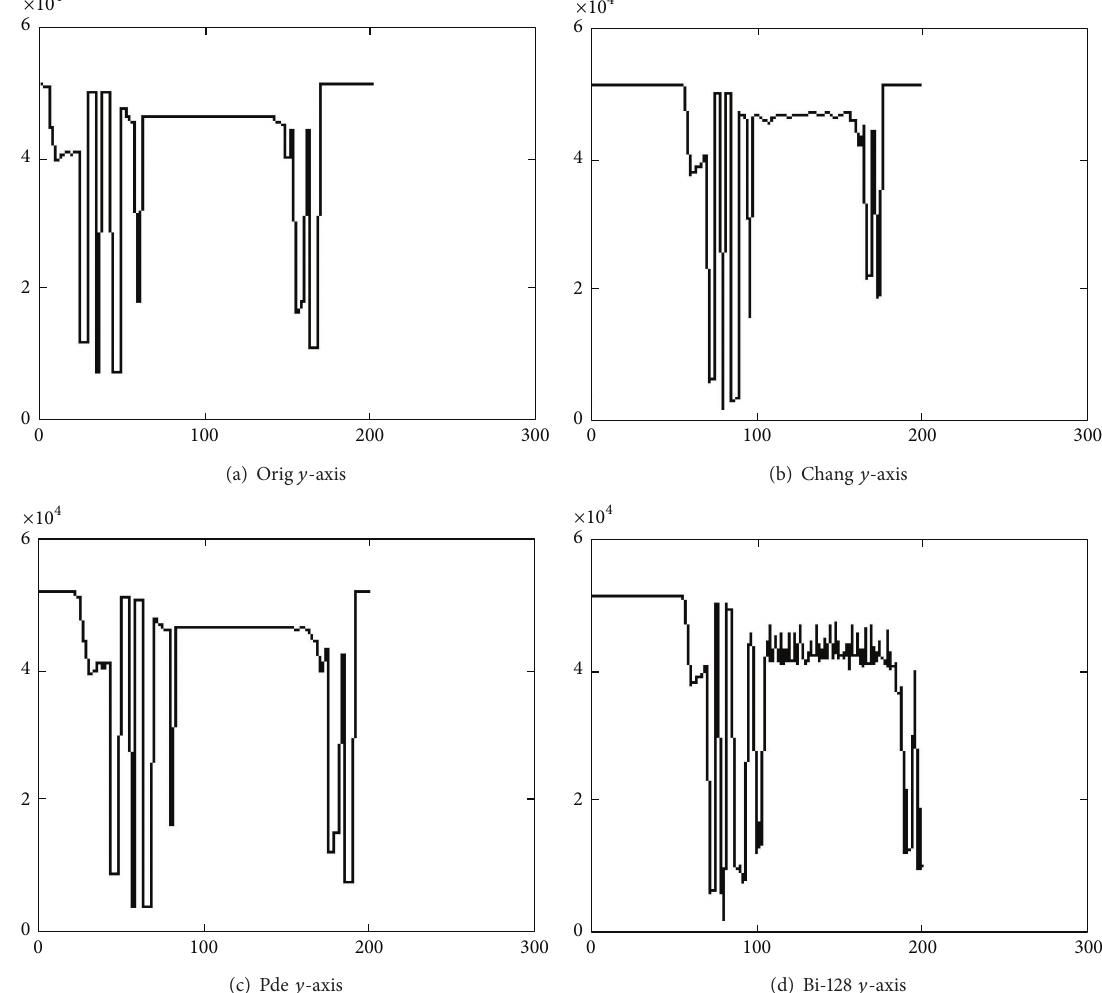
Figure 13: Comparison in Experiment 2: projection of images to the 𝑦 -axis: (a) original image, (b) distorted image, (c) restored image by IEWC, and (d) restored image by the piecewise bilinear